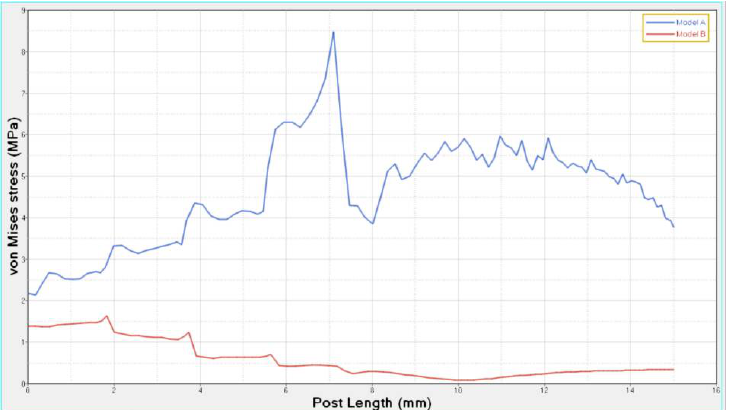
Figure 10. Maximum principal stress distribution at the interface between the post and surrounding structures from the coronal to the apical part.